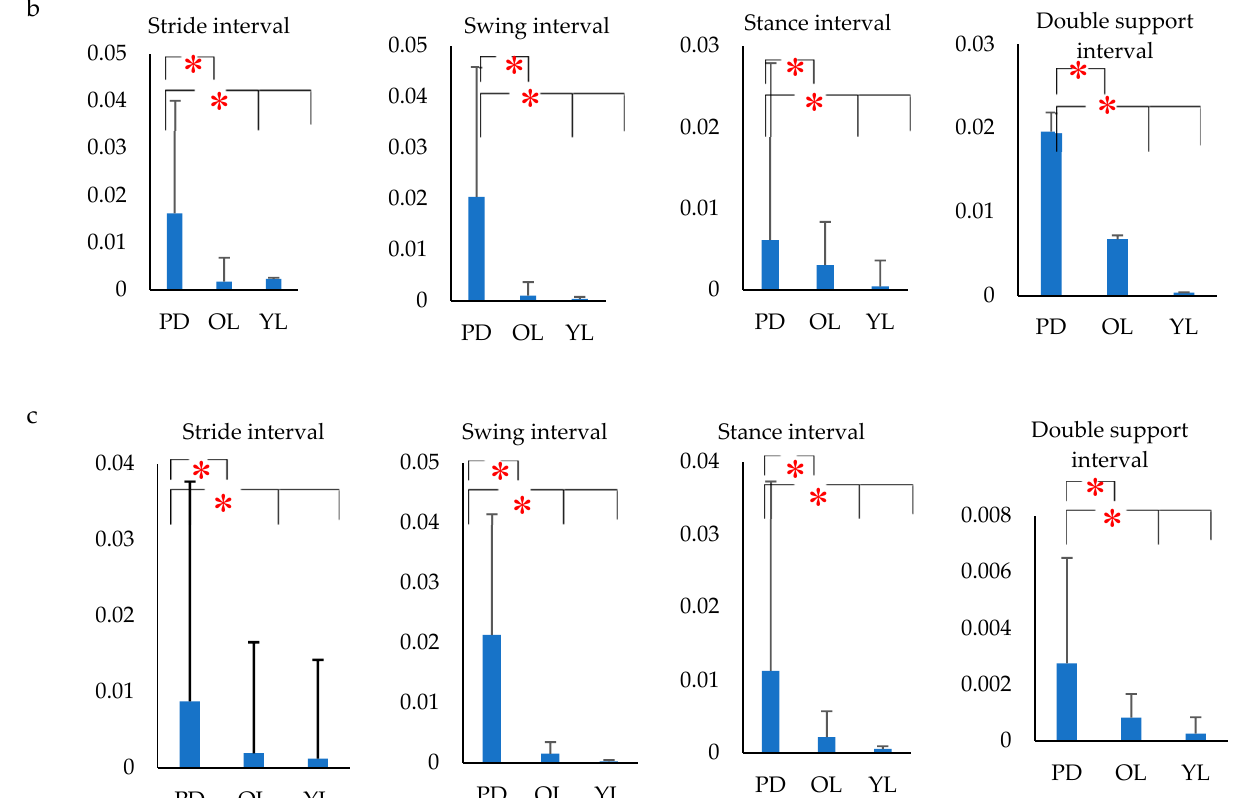
Figure 8. Bar charts showing variance (SD) of stride interval, swing interval, stance interval and double support interval for PD, OL and YL subjects for ( a ) Straight walking ( b ) Turn around a point ( c ) U- turn (* p (Significance) < 0.05).